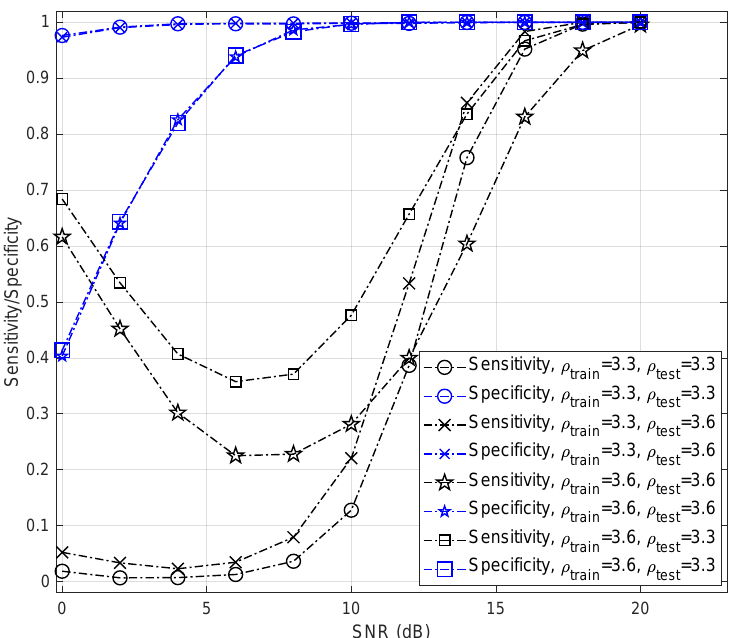
Figure 8. Sensitivity and specificity of LSTM-based classifier under AWGN channel for different values of bifurcation parameters, β = 50, and σ